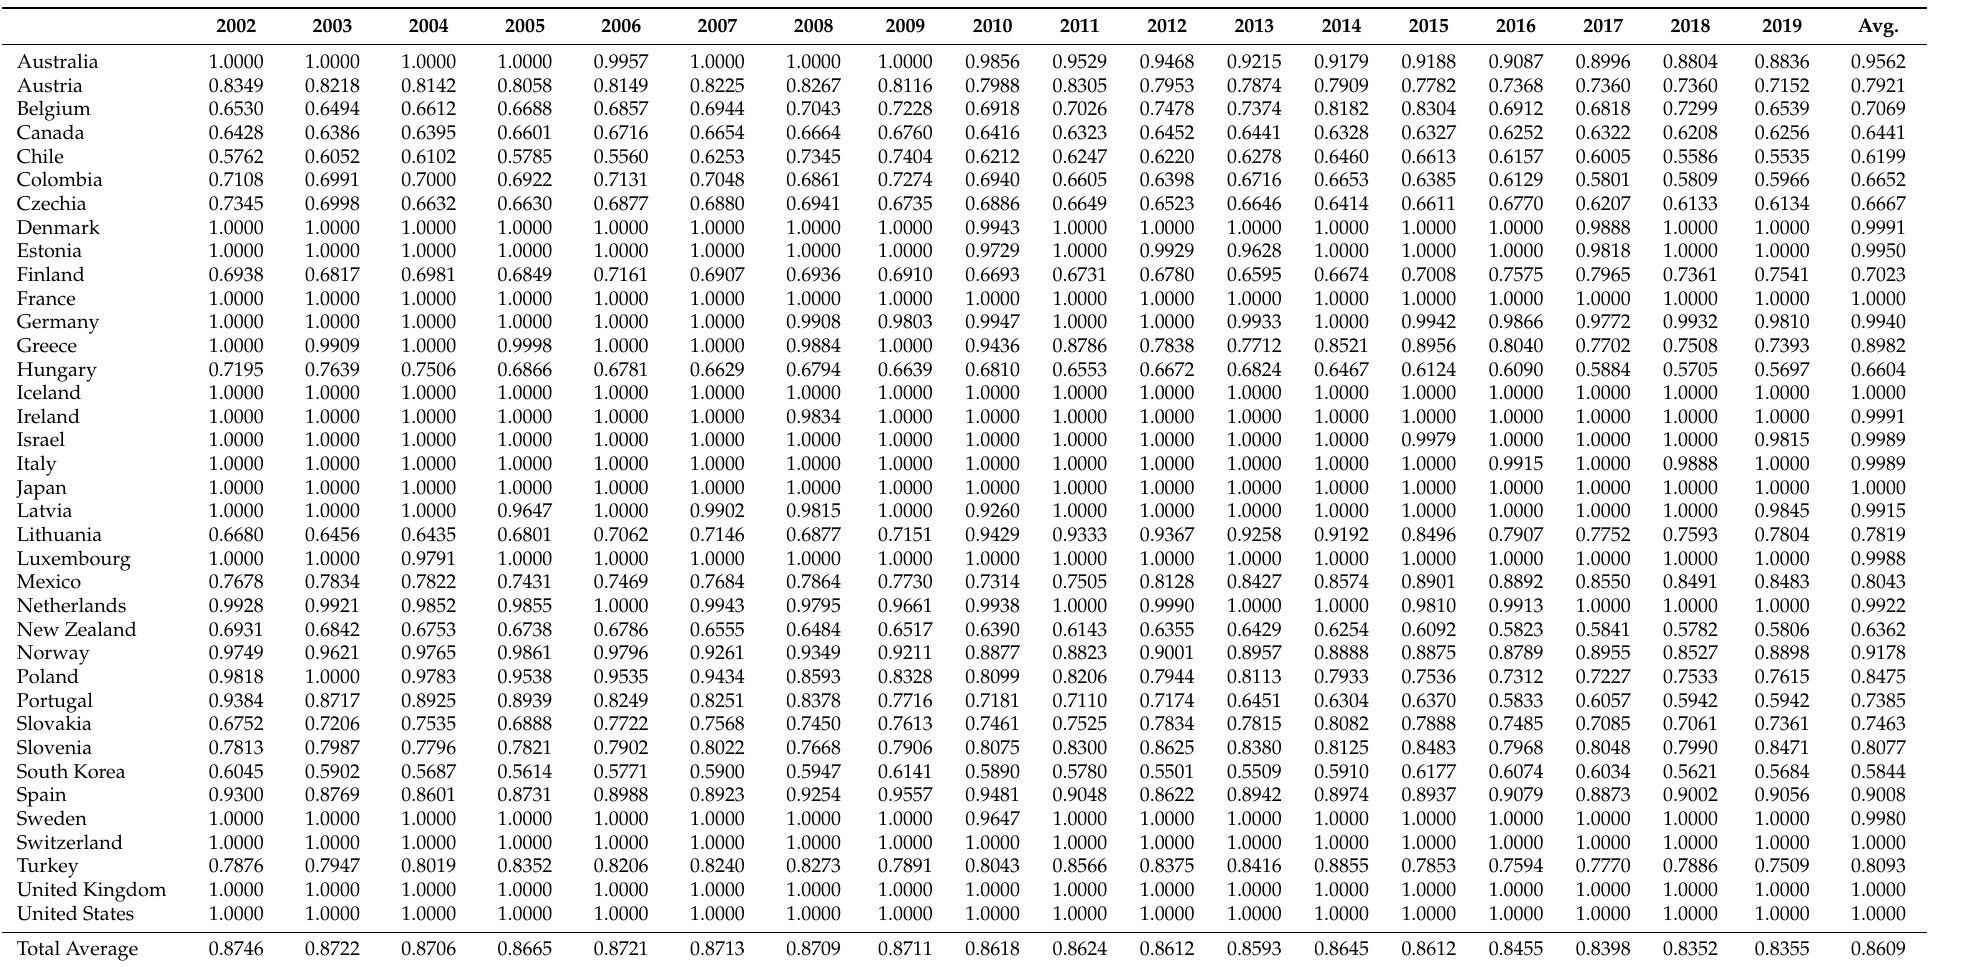
Table 5. Efficiency ( WOE ) measures of OECD